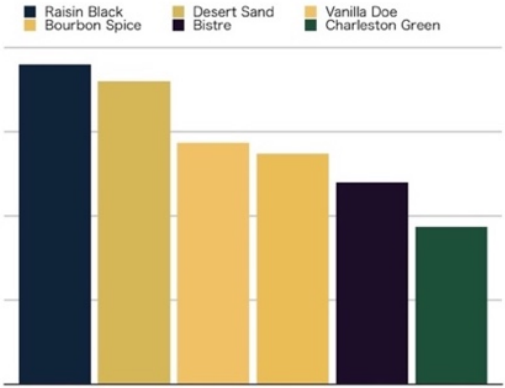
Figure 11. Colors with top 6 highest frequencies.